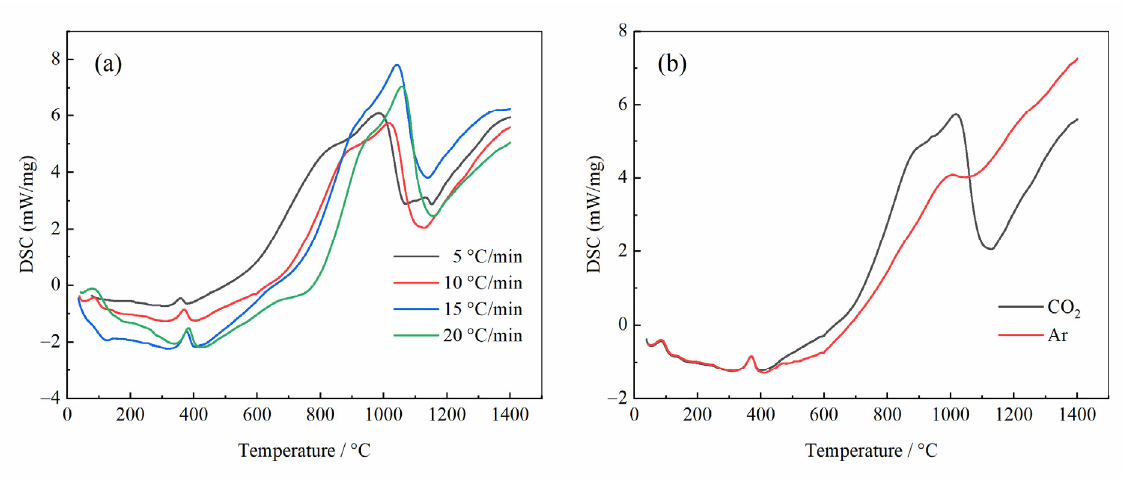
Figure 5. DSC curves of biomass sample: ( a ) different heating rate and ( b ) CO 2 and Ar (10 °C/min). The integration of Equation (20) can be written as Equation (21):